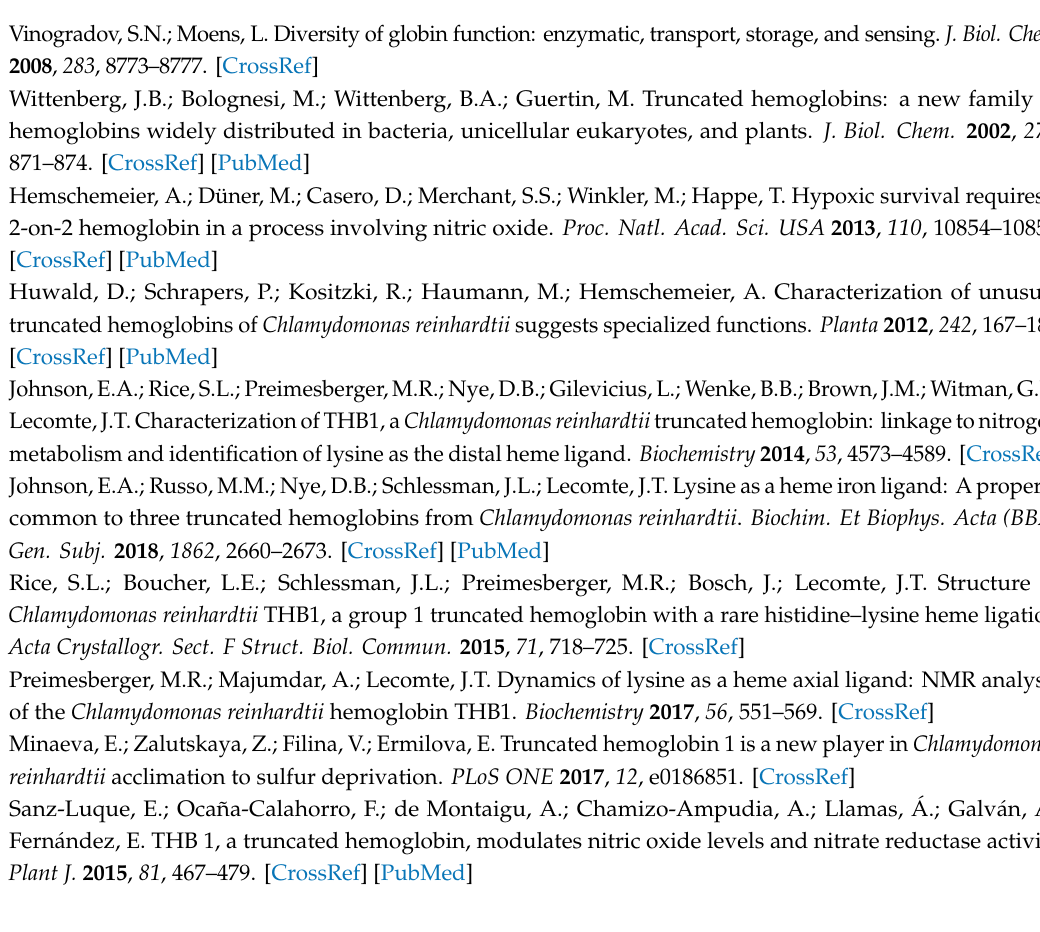
Figure S1: Expression analysis of the NRT2.1 gene in strains 305 and CC124; Figure S2: Expression analysis of the PHOX gene in nitrate reductase-deficient mutants during P starvation; Figure S3: Characterization of amiRNA-THB2 strains; Table S1: Chlamydomonas strains used; Table S2: Primers for RT-qPCR analysis. Author Contributions: Conceptualization, E.E.; Formal analysis, V.F.; Funding acquisition, E.E.; Investigation, V.F. and A.G.; Supervision, E.E.; Writing—original draft, V.F. and A.G.; Writing—review & editing,